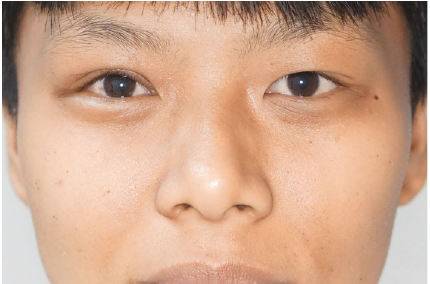
Figure 5: The patient at 3-month